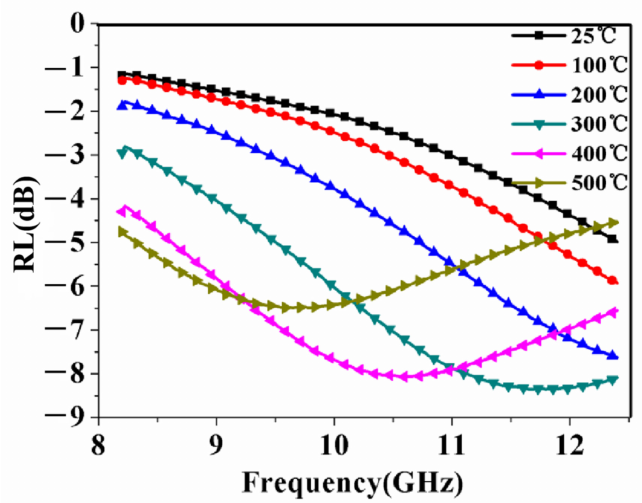
Figure 4. Reflection loss of La 0.5 Sr 0.5 CoO 3 /Al 2 O 3 ceramic versus frequency with different tempera- ture, t = 2